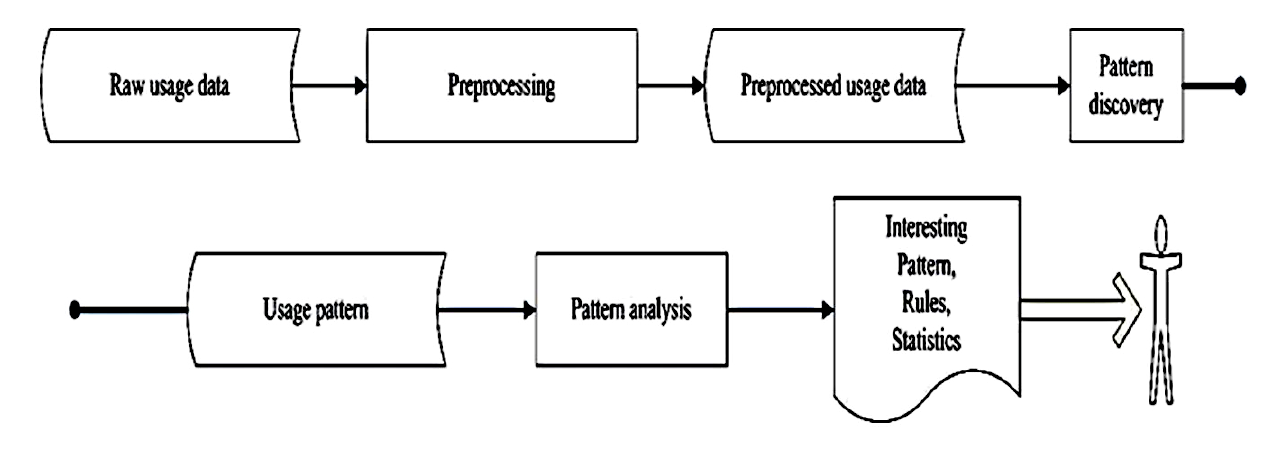
Figure 2. web usage mining